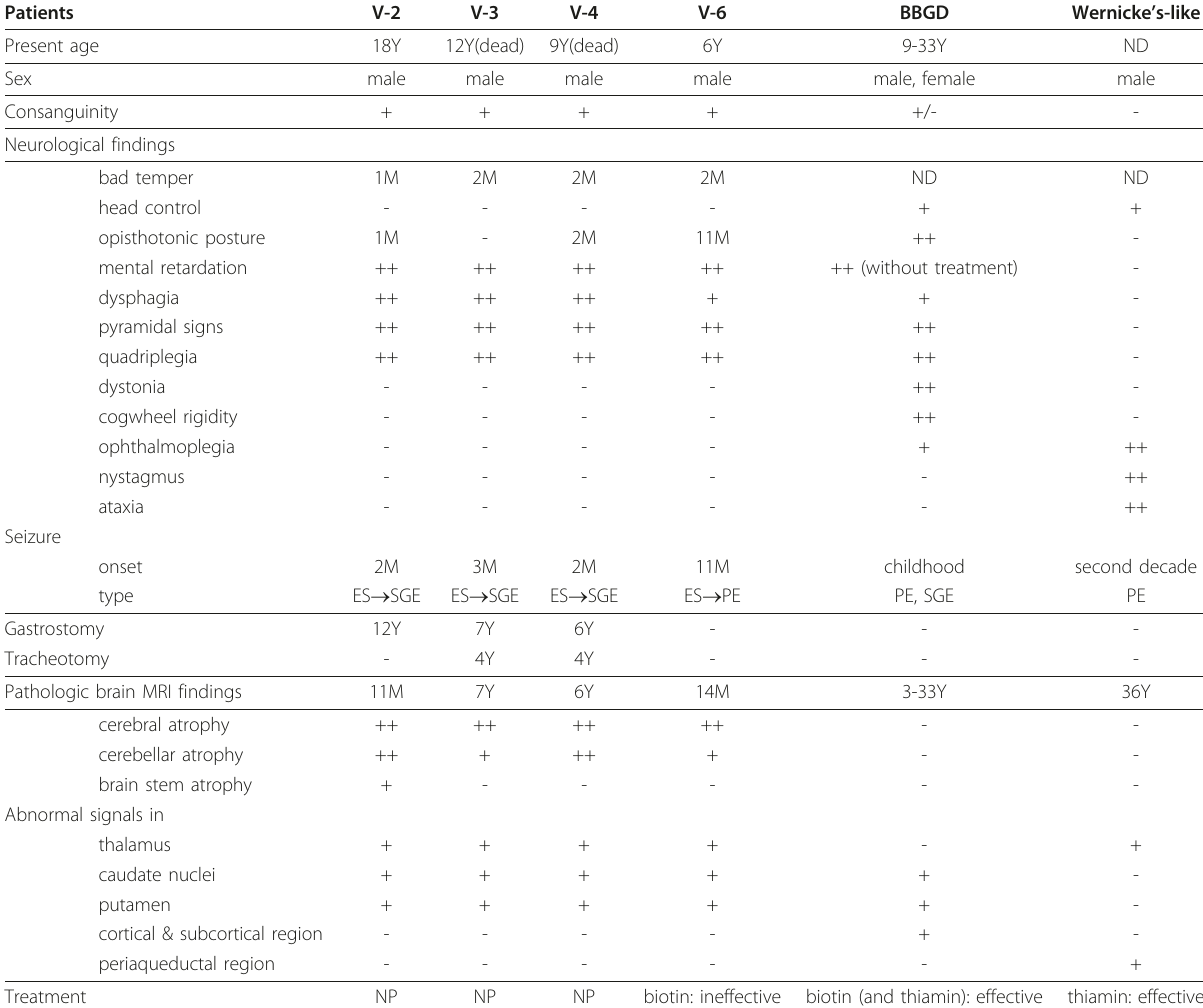
Table 1 Clinical and brain MRI findings of the present patients, BBGD and Wernicke ’ s-like encephalopathy caused by SLC19A3